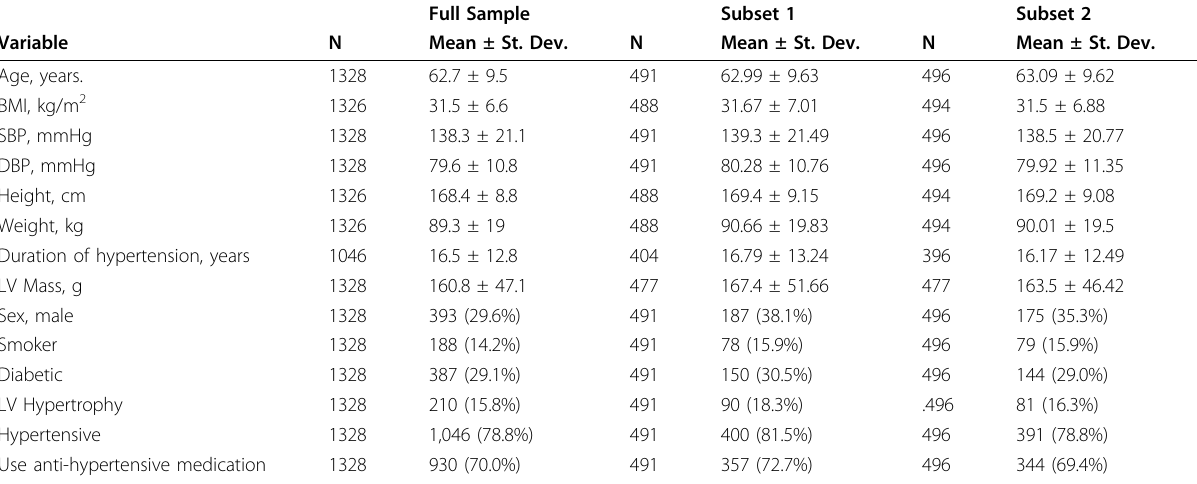
Table 1 Descriptive statistics for the full African-American cohort of GENOA and two internal replication subset